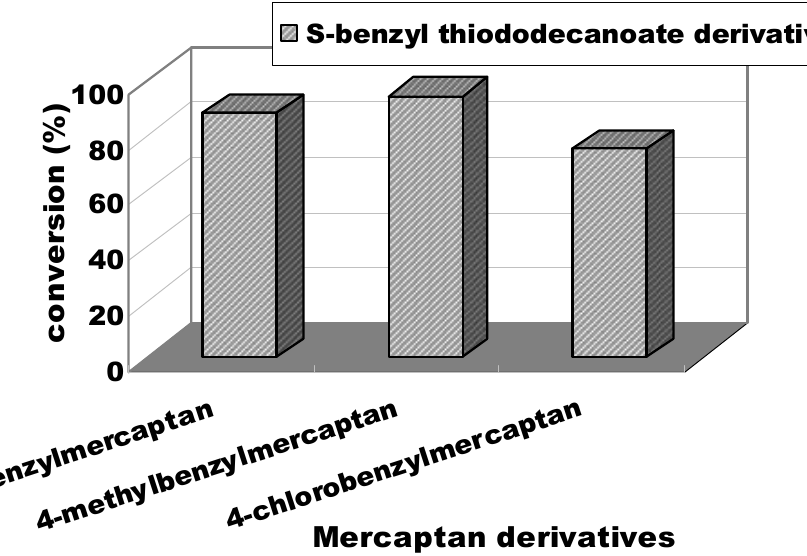
Figure 5. The effect of different substituted groups on benzyl mercaptan on the enzymatic synthesis of thioesters in a continuous flow microreactor. 10.4 µL min −1 feed 1 (4 mmol thiol derivatives in 10 mL DMSO) and 10.4 µL min −1 feed 2 (8 mmol vinyl esters in 10 mL DMSO) at 50 °C (residence time 30 min), Lipozyme TL IM (0.87 g, 44 mg mL −1 ).